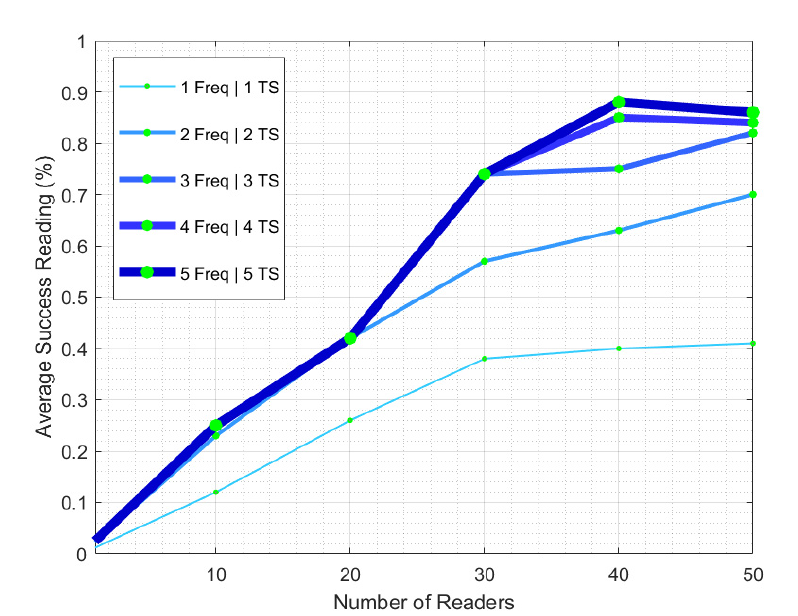
Figure 11. System performance vs. number of readers according to frequency and time slot .